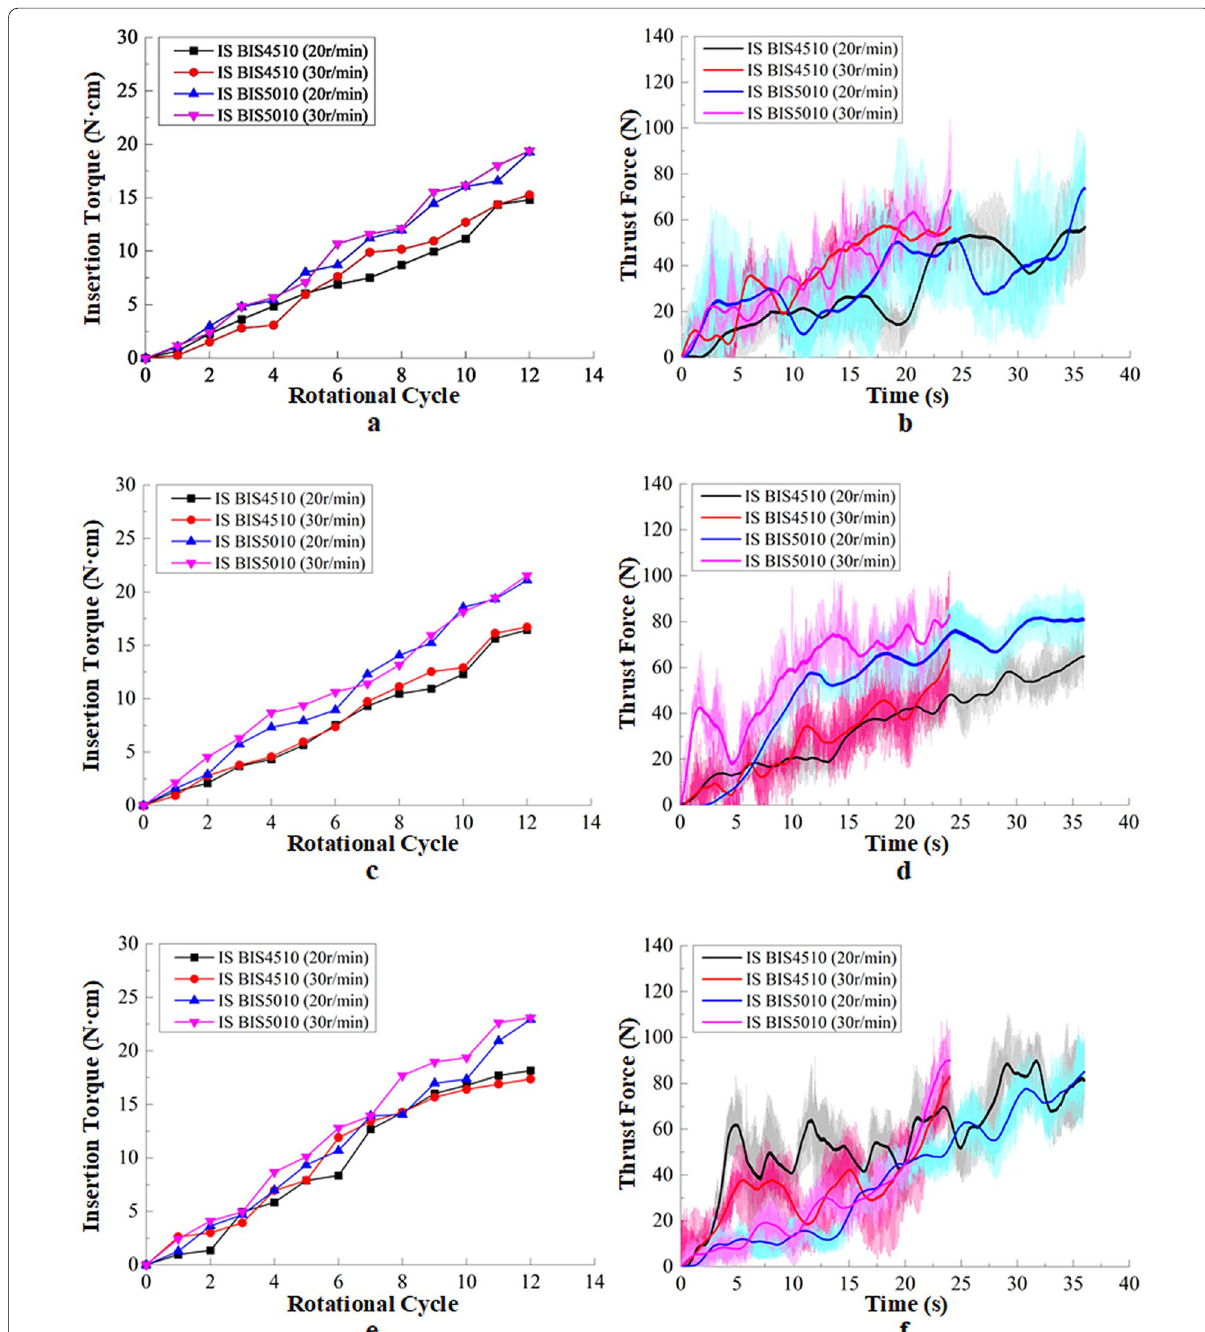
Figure 6 The insertion torques and thrust forces obtained by insertion experiments: a – f data of IS implants, a and b , c and d , e and f were insertion torques and thrust forces of 235–245Hu, 345–355 Hu and 415–425 Hu, respectively; g – l data of ITI implants, g and h , i and j , k and l were insertion torques and thrust forces of 235–245Hu, 345–355 Hu and 415–425 Hu,